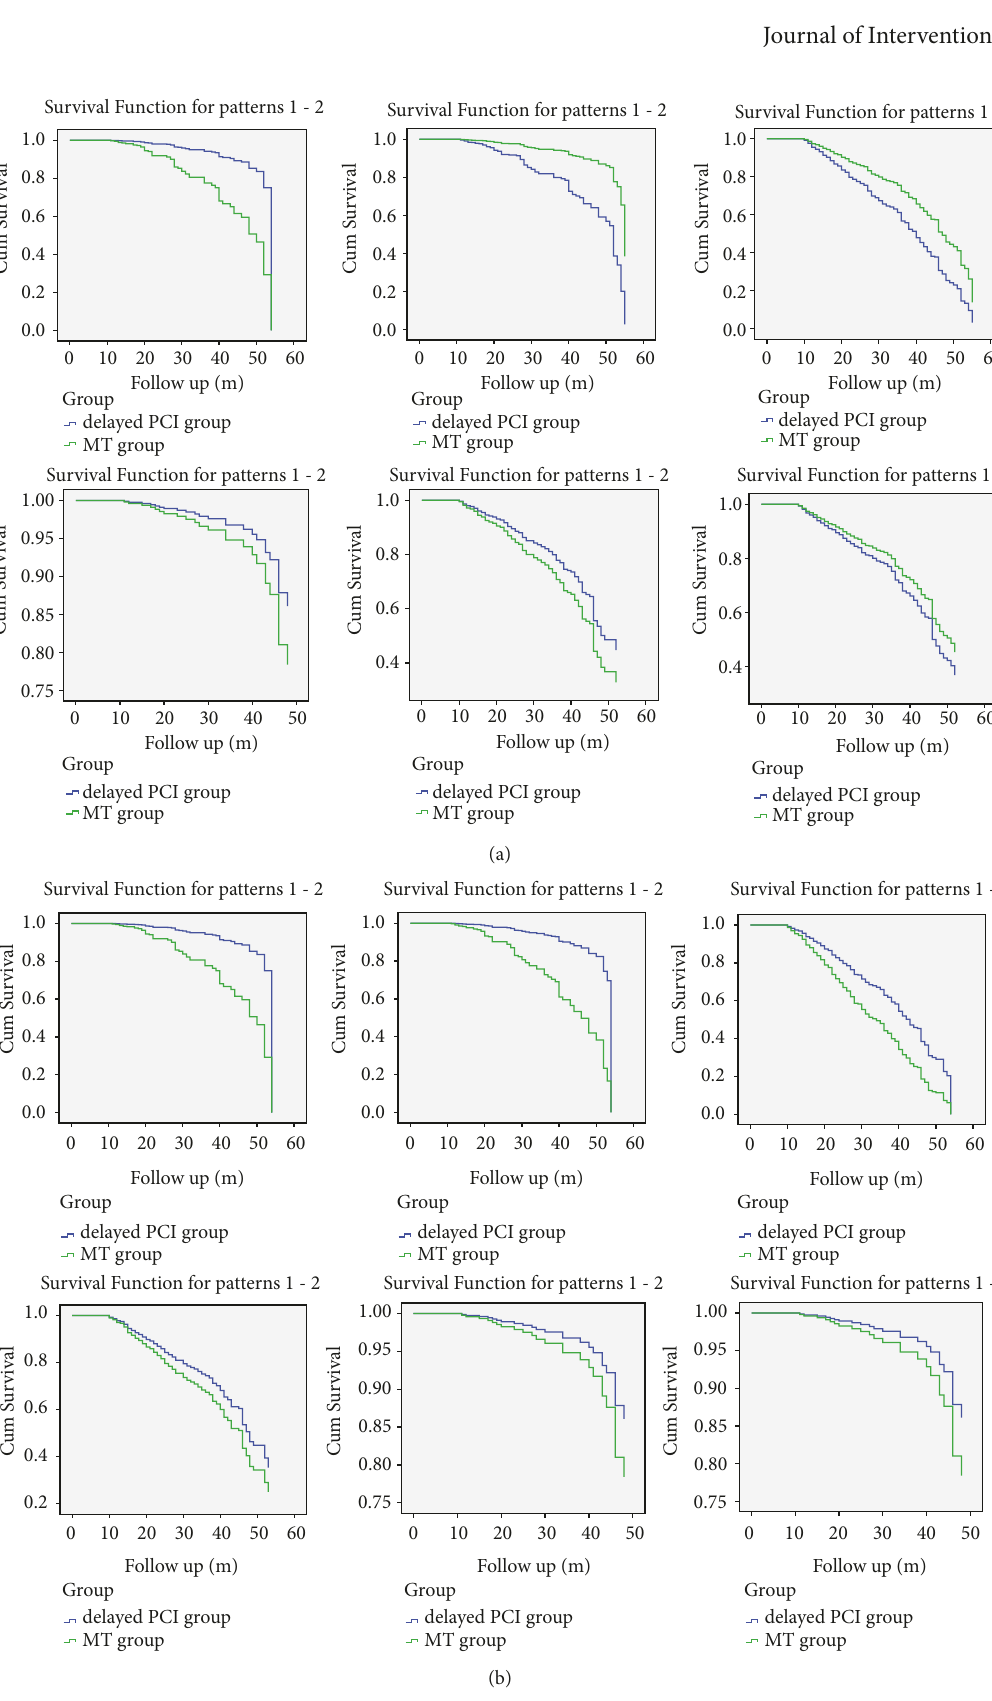
Figure 1: Kaplan-Meier curves for event (ACM, CM, MACEs, Rehospitalization for HF, Revascularization, and Stroke, respectively) free survival according to therapy for STEMI after 12 hours of the onset of symptoms. (a) Before matching; (b) after